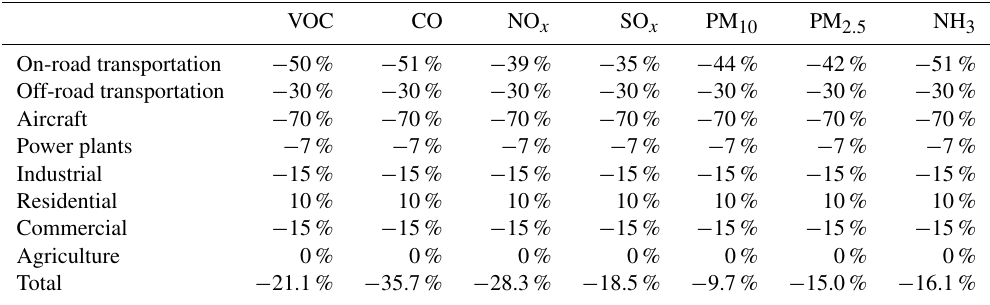
Table 2. The percentage of changes in air pollutant emissions during the COVID-19 lockdown relative to a hypothetical scenario without the lockdown in southern